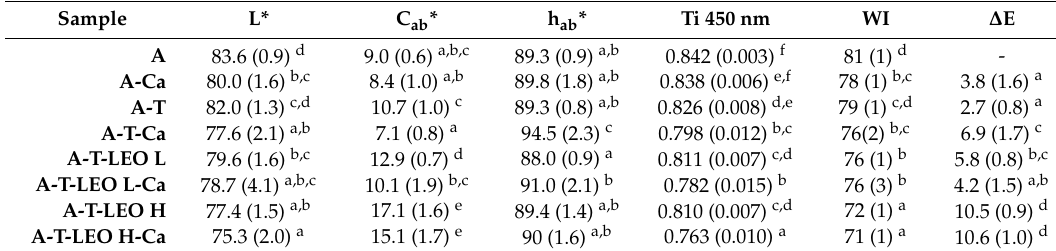
Table 3. Lightness L*, chrome C ab *, hue h ab *, whiteness index (WI), total color di ff erence ( ∆ E) values and internal transmittance (Ti) at 450 nm of developed